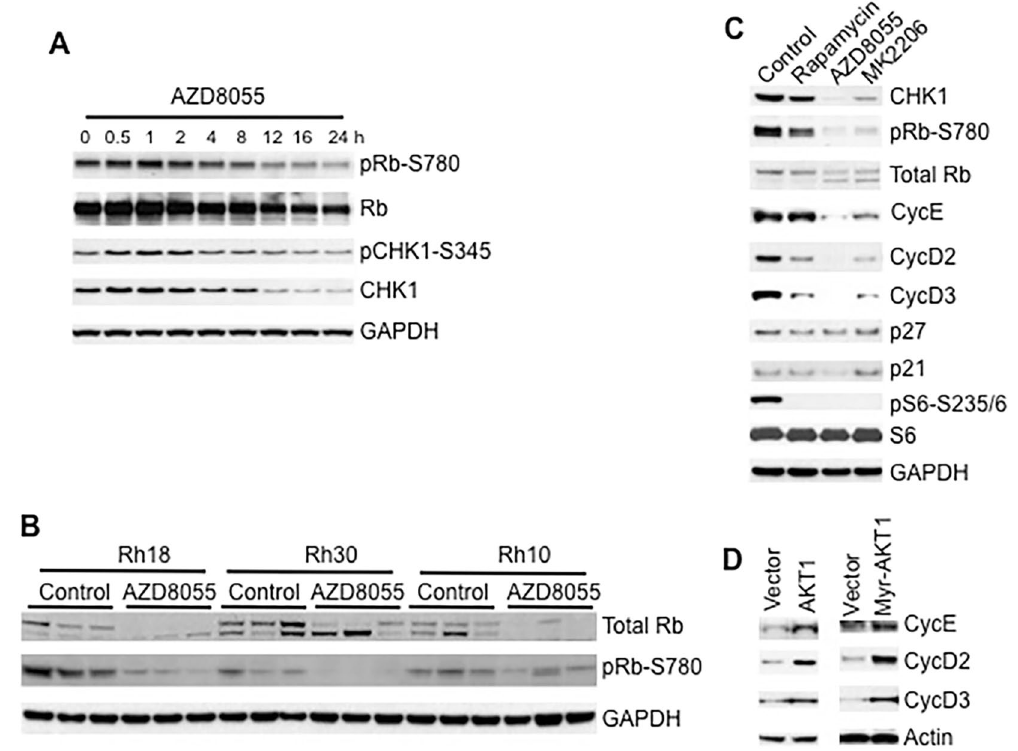
Figure 4. The mTOR Pathway Regulates the Activity of Cyclin D/CDK4/6 and Cyclin E/CDK2. ( A ) Rh30 cells were treated with AZD8055 (1 μ M) for the time points as indicated, total proteins were extracted for immunoblotting. ( B ) 24 hr post treatment on day 4, protein extracts of Rh18, Rh30 and Rh10 tumor xenograft models treated with vehicle (Control) or AZD8055 at 20 mg/kg/day were used for immunoblotting to detect the protein levels of Rb and pRb-S780. Three tumors were randomly picked for each group. ( C ) Rh30 cells were treated with rapamycin, AZD8055 or MK2206 for 16 hr. Total proteins were extracted for immunoblotting. ( D ) Rh30 cells were transfected with vector, AKT1 wt, or myr-AKT1 plasmid. 48 hr later, total proteins were extracted for immunoblotting. Immunoblots were converted to gray with auto tone by Photoshop